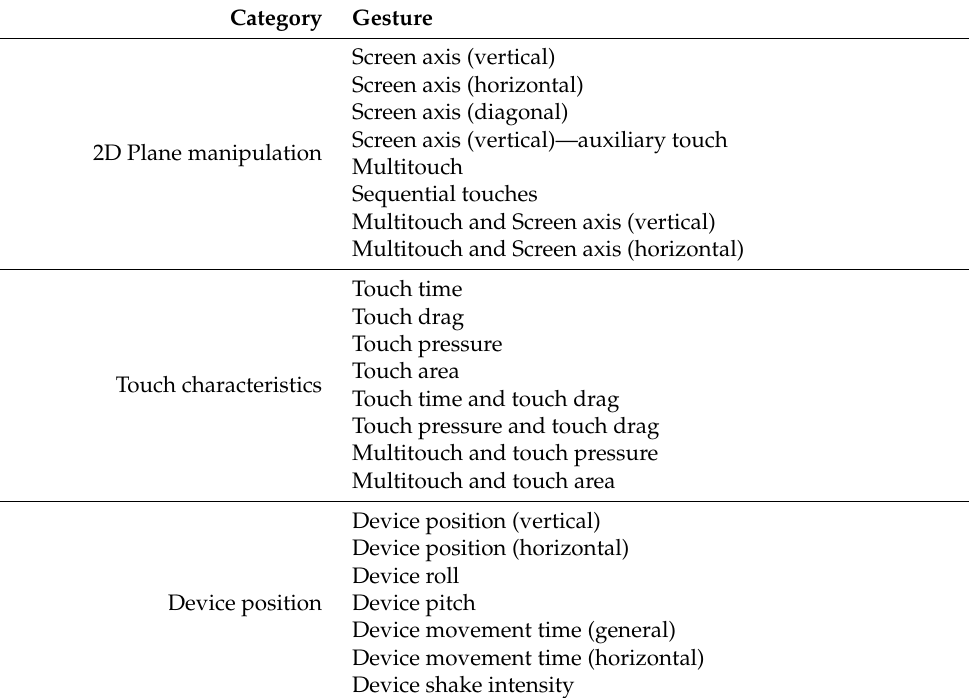
Table A1. Categorization of participants’ gestures in the